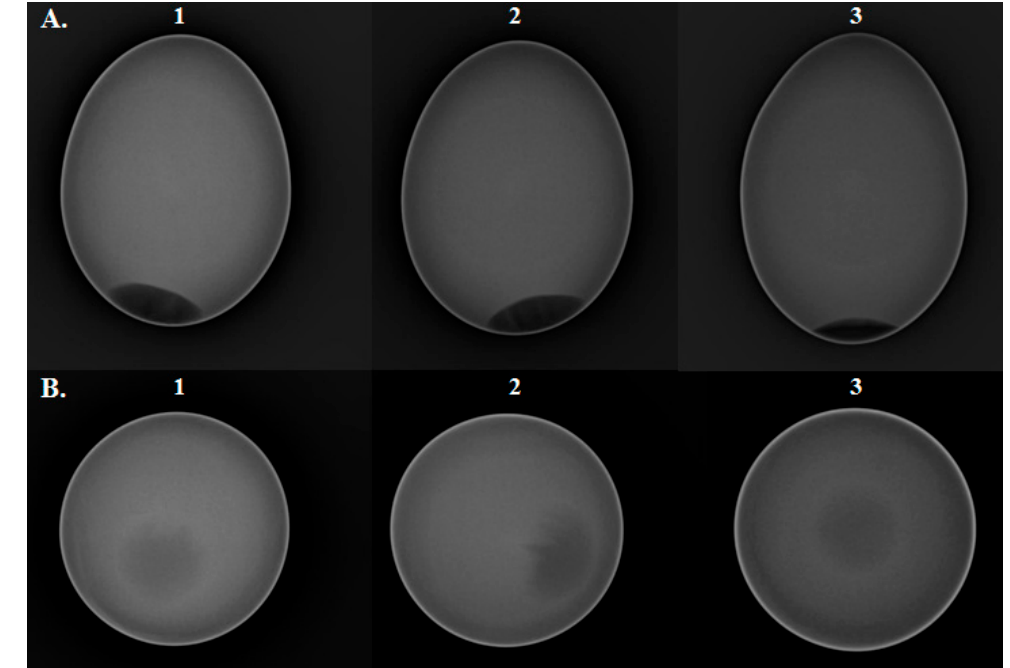
Figure 2. Comparison of photometric interpretation of monochrome images under the Digital Imaging and Communications in Medicine (DICOM) standard for eggs of three different qualities imaged at 50 kVp and 20 mAs: ( A ) median and ( B ) axial plane images. (1) special organic (SO) eggs, (2) general organic (GO) eggs, and (3) conventional (CO) eggs.